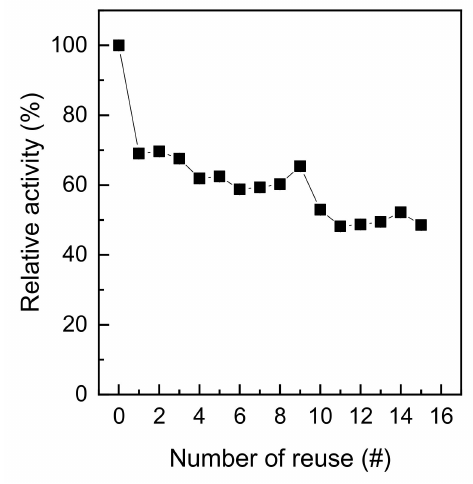
Figure 9. Reusability of immobilized